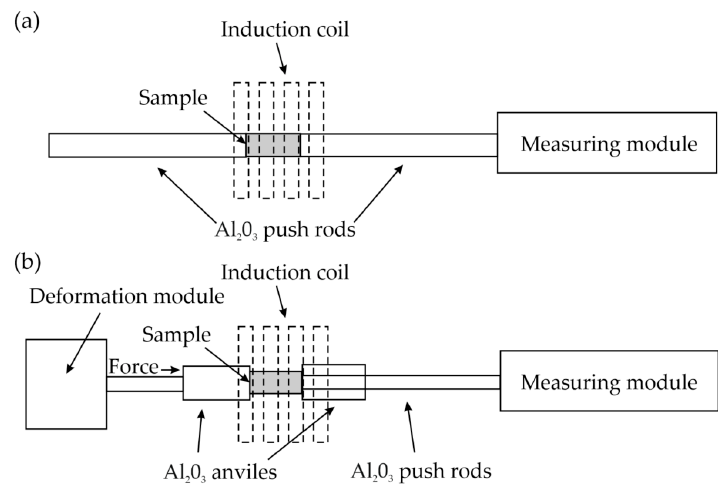
Figure 2. Schematic illustration of the used: ( a ) thermal and ( b ) deformation modules.